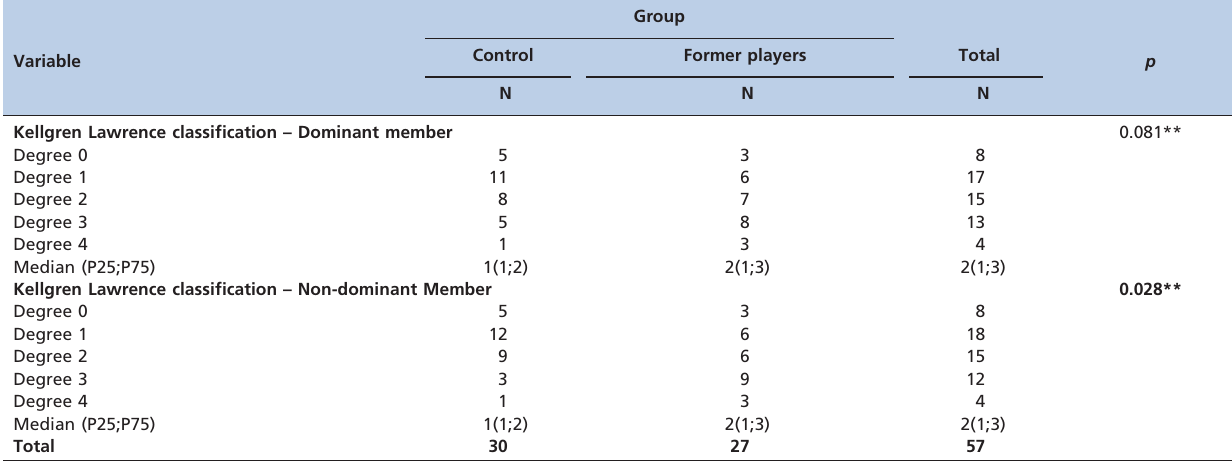
Table 3 - Osteoarthritis classification distribution comparison in dominant and non-dominant members between groups.